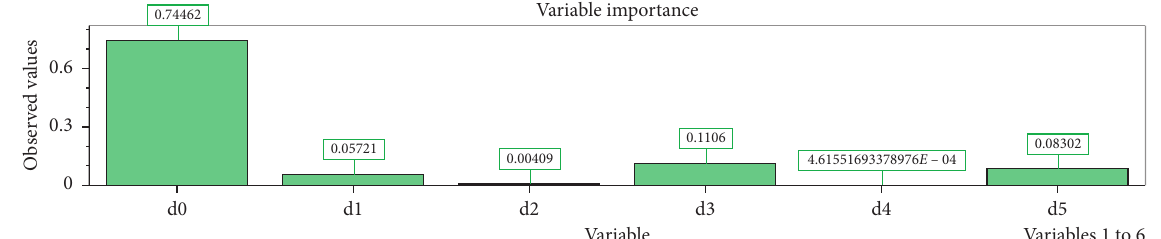
Figure 5: UCS variable importance of observed values and the input variable; (d0) HARHA; (d1) w (d6) δ max .